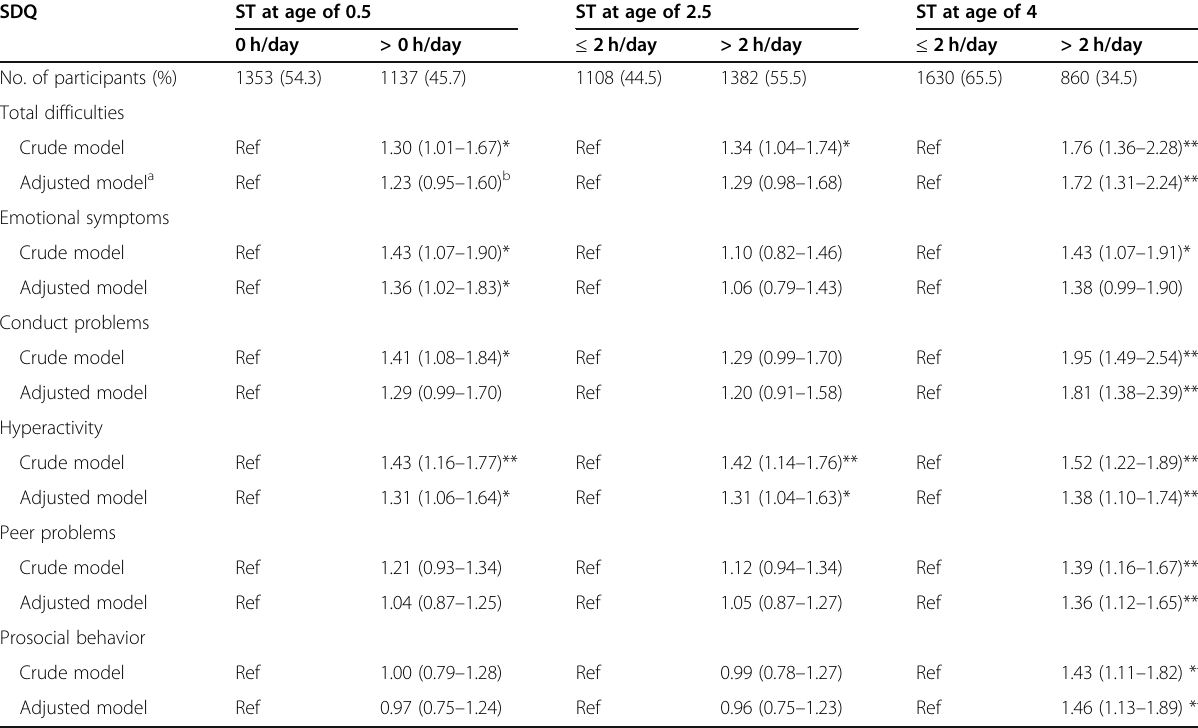
Table 2 Odds ratios (95% confidence intervals) of emotional and behavioral problems associated with screen time ( n = 2490) SDQ ST at age of